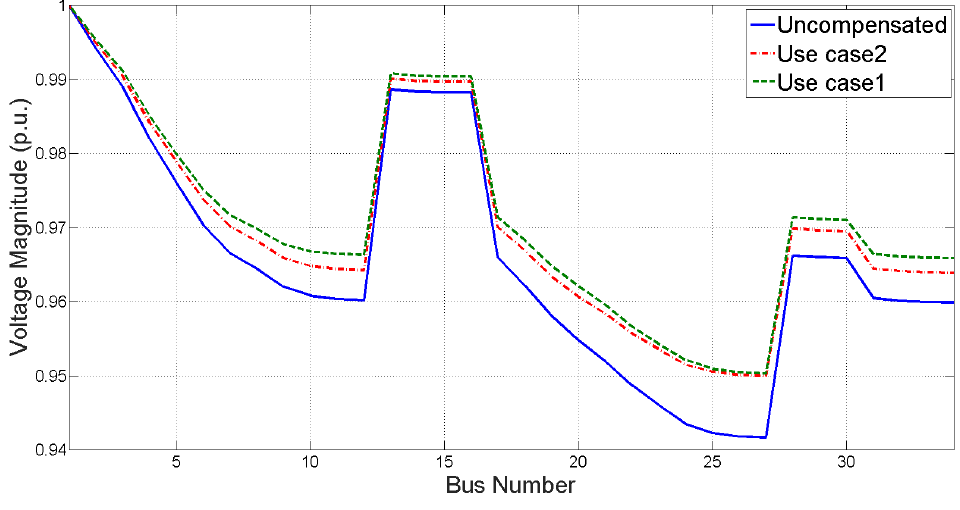
Figure 6. Voltage profile for N 1 in CS 1 .